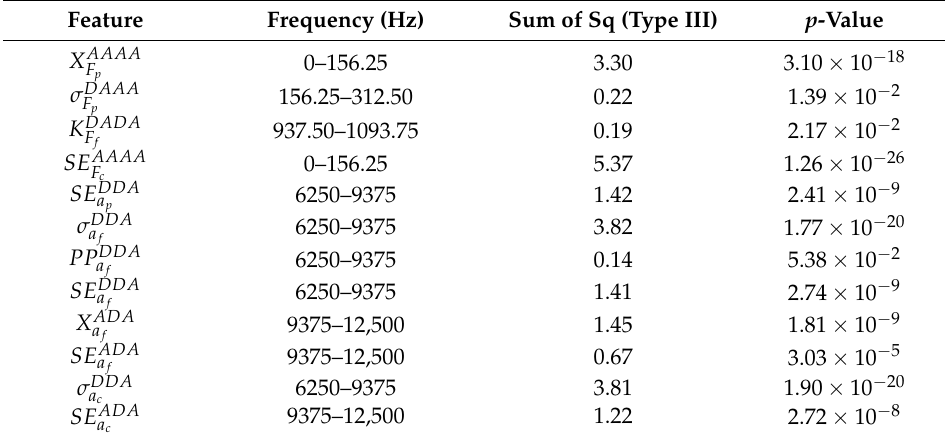
Figure 19. Estimated data versus experimental validation data for the parameter Ra with multi-sensor data fusion for the ( a ) TDA + PSD, ( b ) SSA, ( c ) WPT methods, and ( d ) model reliability. Table 2. Significant signal feature extraction of the optimum model obtained with WPT